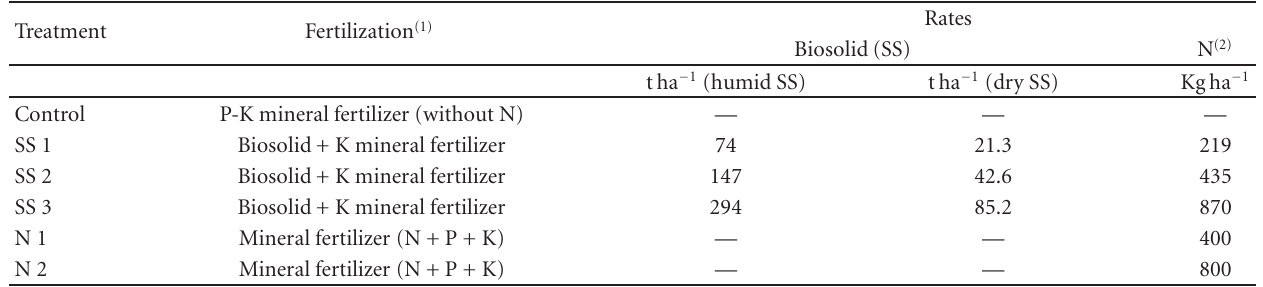
Table 2: Description of treatments with biosolids (SS) and mineral fertilizers.